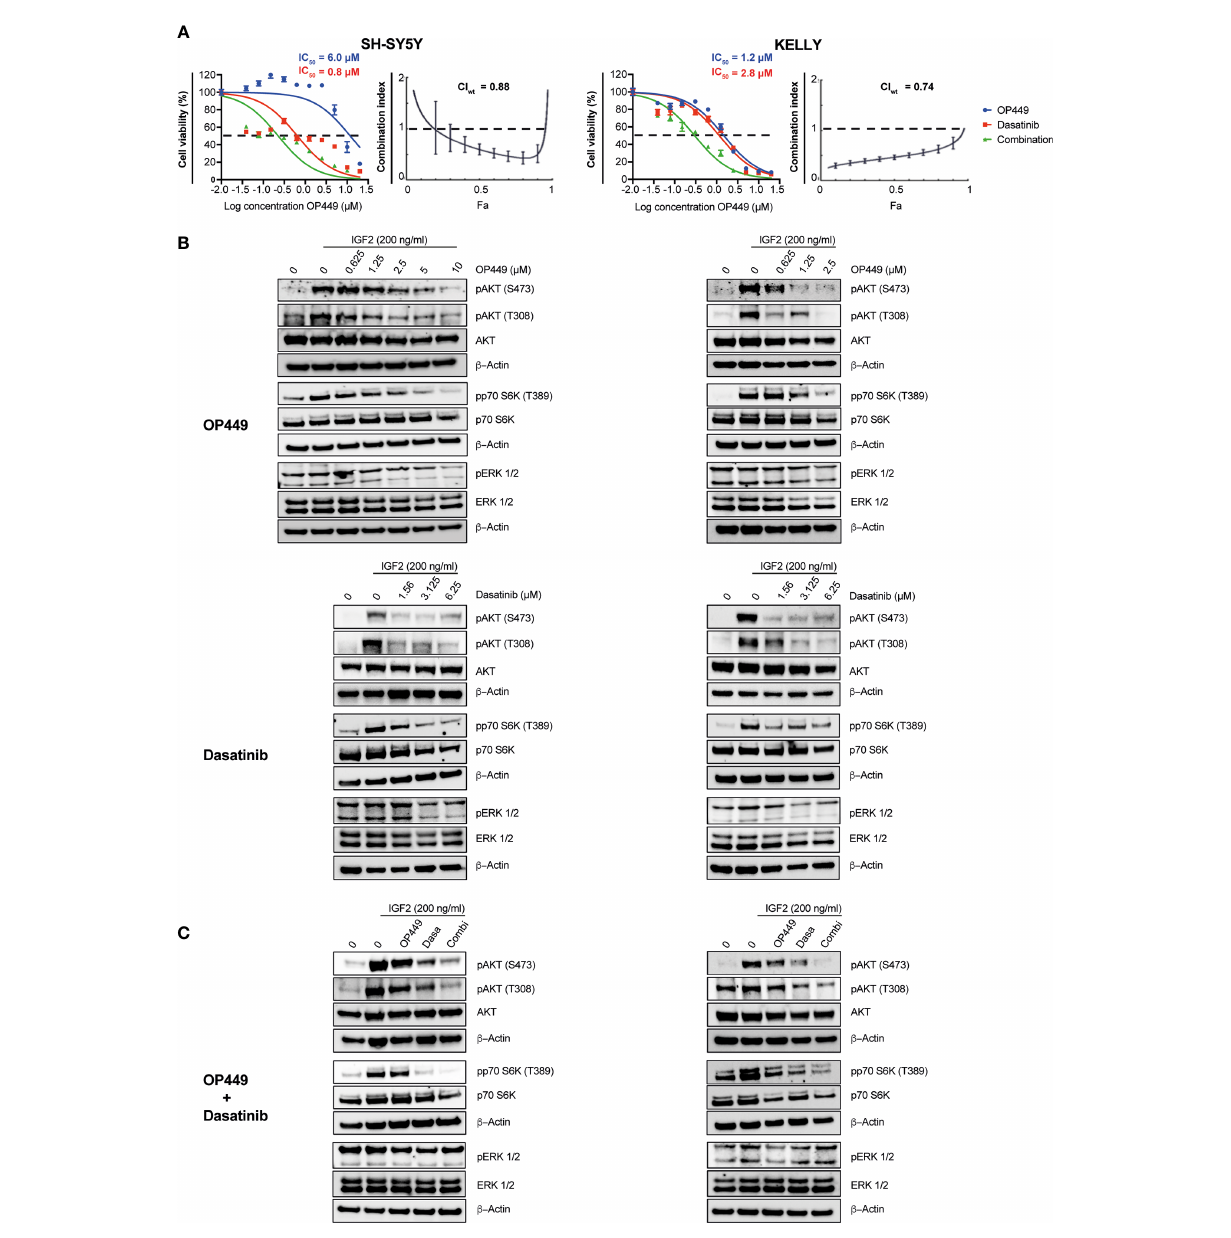
FIGURE 6 | Synergy of OP449 and dasatinib in SH-SY5Y and KELLY neuroblastoma (NB) cells. (A) OP449 and dasatinib synergistically decrease viability. Cells were treated for 72 h with OP449, dasatinib, or a combination of both. Cell viability was determined by MTT assay and is depicted as a percentage of untreated cells, with IC 50 values being shown. Dose – response curves for SH-SY5Y cells are plotted as log of OP449 concentrations ranging from 0 to 20 µM at a molar ratio of 1 (OP449) to 4 (dasatinib) and for KELLY cells as log of OP449 concentrations from 0 to 20 µM at a molar ratio of 1 (OP449) to 2.5 (dasatinib). Combination index (CI) and weighted average combination index (CI wt ) were determined according to the Chou – Talalay method. Fa (fraction affected) – CI plots are shown, and the CI wt is stated. A CI or CI wt of less than 1 indicates synergy, 1 an additive effect, and greater than 1 an antagonist effect. The vertical bars on Fa-CI plots represent 95% con fi dence intervals based on sequential deletion analysis (SDA) using CompuSyn (41). Experiments were repeated three times. (B) OP449 and dasatinib inhibit activating phosphorylation of AKT and p70S6K. Cells were treated with increasing doses of OP449 for 4 h (top panels) or of dasatinib for 2 h (bottom panels) before being stimulated with IGF2 for 30 min. Western blotting of total lysates is shown. b -Actin was used as loading control. Full-length Western blotting is shown in Supplementary Figures 3 – 6 . (C) OP449 and dasatinib synergize in decreasing activating phosphorylation of AKT and p70S6K. SH-SY5Y cells were treated with 1.25 µM of OP449 for 4 h, 3.125 µM of dasatinib (Dasa) for 2 h, or a combination (Combi) of both drugs. KELLY cells were treated with 2.5 µM of OP449 for 4 h, 6.25 µM of dasatinib (Dasa) for 2 h, or a combination (Combi) of both drugs. Cells were then stimulated with 200 ng/ml of IGF2, and their lysates were analyzed by Western blotting. Full-length Western blotting is shown in Supplementary Figures 7, 8